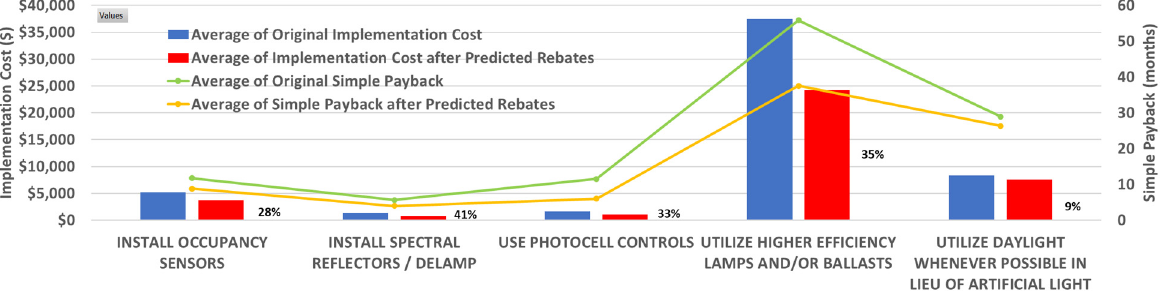
Figure 5. Reductions in implementation cost and simple payback due to rebate value predictions.